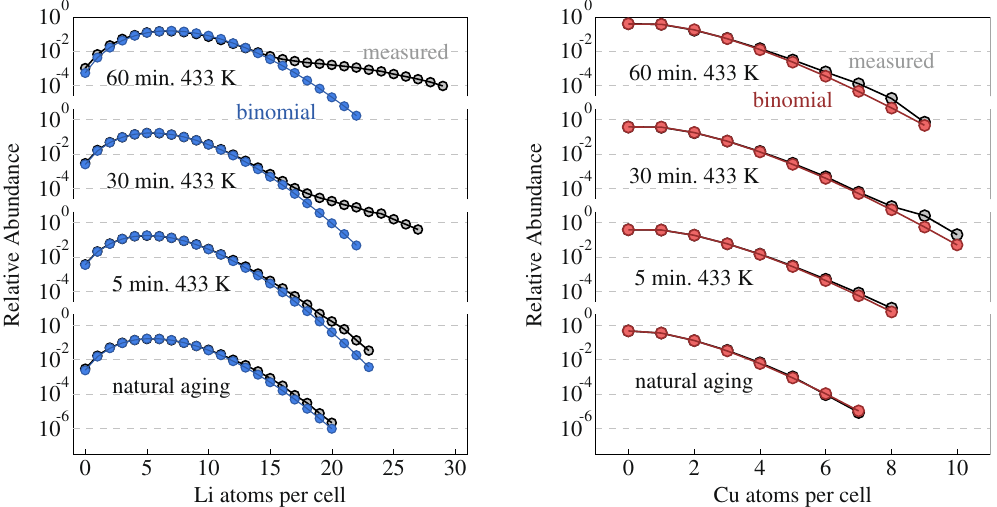
Figure 4. Li and Cu distribution analysis in naturally aged, 5 minutes at 433 K aged, 30 minutes at 433 K aged and 60 minutes at 433 K aged condition (cell size of 100 atoms).